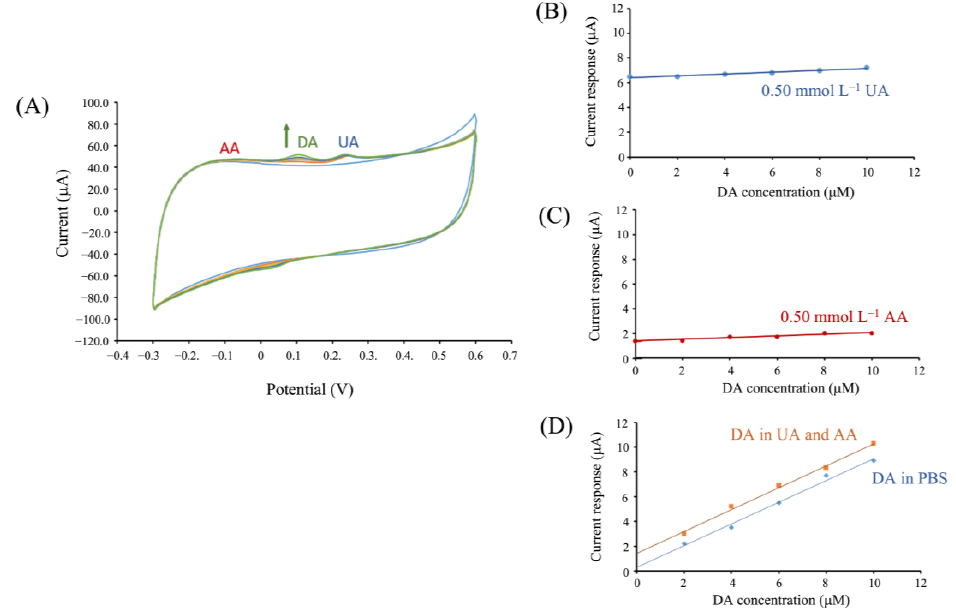
Figure 5. ( A ) Cyclic voltammograms in 0.10 mol L − 1 PBS at pH 7.40 containing 0.50 mmol L − 1 AA, 0.50 mmol L − 1 UA, and the series of DA concentrations from 2.0 to 10 µ mol L − 1 DA at the OMC-PEDOT-PSS/SPCE. ( B , C ) The graphs show the mutual effect of UA, and AA plotted the change in current response of each substance versus DA concentration, respectively. ( D ) The graph compares between dopamine signal in PBS and in both UA and AA interferences.